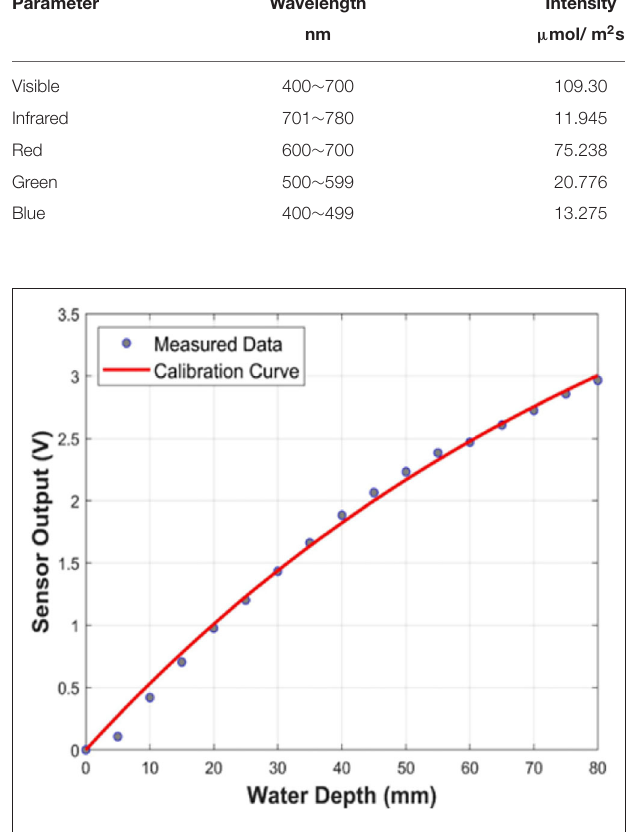
TABLE 1 | The spectral output of the LED lights used in growing microgreens. Parameter